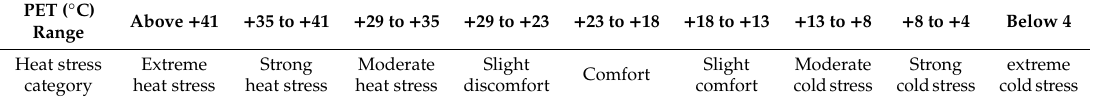
Figure 11. ( a ) The percent of the time that the mean daytime T mrt is above 41 °C during the hottest Figure 10. ( a ) The distribution of the sky view factor resulted from the building design and the spread period of days (12:00–19:00); ( b ) the percent of the time which the area covered sunlit during the of focal spots all over the site; ( b ) the distribution of mean daytime T mrt classified by PET index; ( c ) hottest period of days (12:00–19:00). the distribution of mean T mrt classified by PET index through the hottest period of the days (12:00– 19:00). Table 3. Thermal sensitivity and grads of physiological stress, according to Mayer and Matzaraki [44].